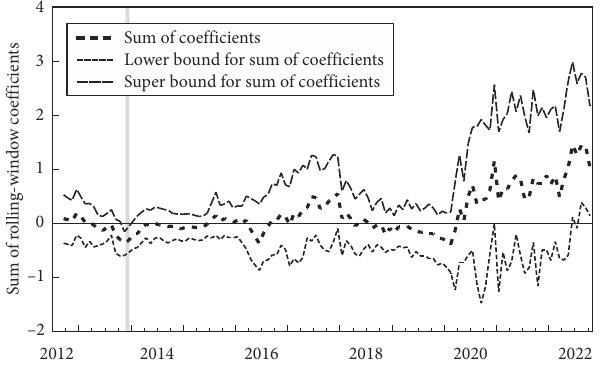
Figure 5. The coefficients of the influence from BP to GSCP (source: authors’